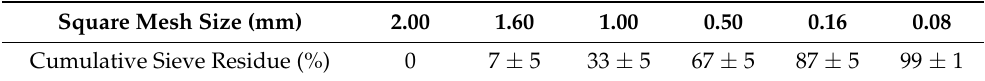
Table 2. Particle size distribution of the CEN Standard